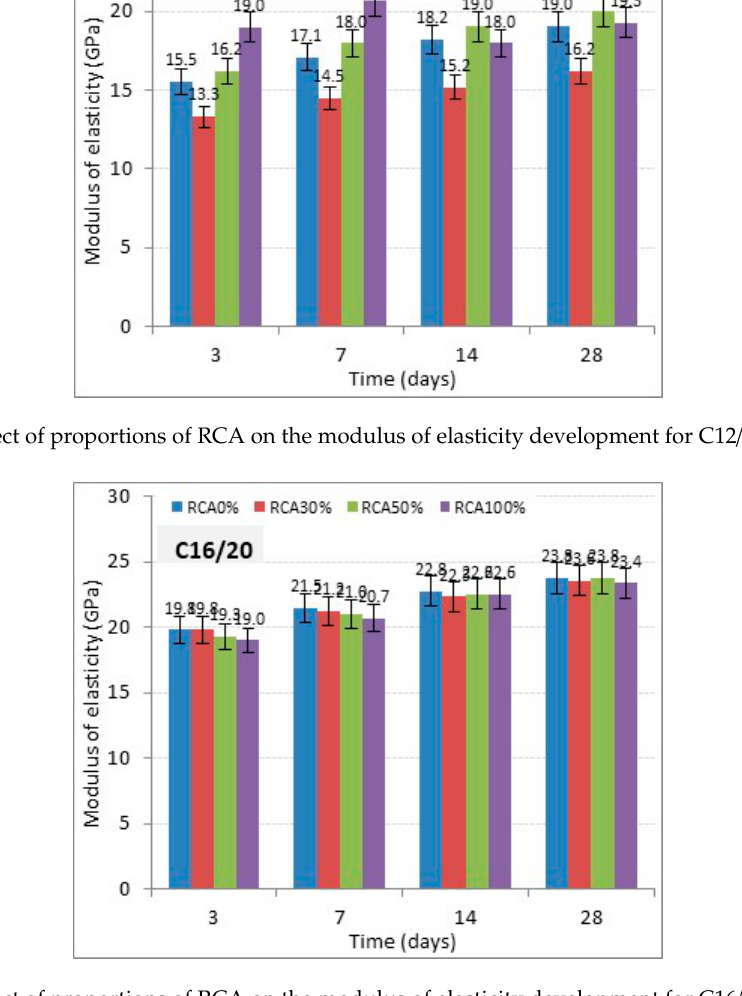
Figure 7. Effect of proportions of RCA on the modulus of elasticity development for C25/30 concretes. 3.2.3. Flexural strength The results of flexural strength are displayed in Figures 8–10. Independently of the type of aggregates used, the flexural strength increases when increasing the concrete grade and reducing its w/c ratio. Overall, the flexural strength ranged from 1.8 to 3.5 MPa, depending on the concrete grade and the percentage of RCA incorporated in the concrete. The usage of RCA in a partial/full replacement of NCA has led, generally, to a decrease in the flexural strength of concrete. Similar to the compressive, splitting tensile strengths and modulus of elasticity, some discrepancy of the results could be identified due to the large variations in the source and quality of the used RCA. The flexural strength reduction of the RCA ‐ concrete is attributable to the weakness in the bonding strength, linking the aggregate fraction and the cement paste. The weakness of this interfacial transition zone (ITZ) is strongly linked to the RCA characteristics. The porous and inferior strength of the old mortar that adhered on the RCA contribute greatly to the weakness of this bonding strength between the aggregate skeleton and the cement paste, as also reported by